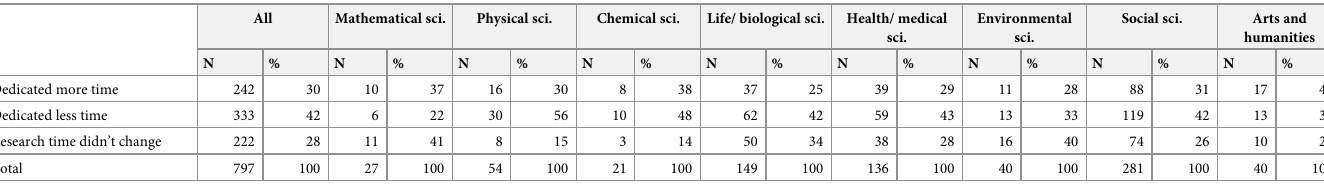
ECRs from the physical sciences formed the largest percentage of those who said they dedi- cated less time to research (56%), and they were followed by those from the chemical sciences (48%) (Table 4). The highest percentage of those who said that they dedicated more time were from arts and humanities (43%) and then from the chemical sciences (38%). The largest per- centage saying there was no change in research time devoted were from the mathematical sci- ences (41%) and environmental sciences (40%) ( X 2 = 30.3, df = 16, p = .005). Quite expectedly, those with caring responsibilities were more likely to dedicate less time to their research than before the pandemic (47.9% of those with vs 37.2% of those without caring responsibility) ( X 2 = 9.02, df = 2, p = .01), and those without caring responsibilities were more likely to dedicate more time to their research (32.6% of those without vs 27.4% of those with caring responsibili- ties). There was no gender or age difference. As illustrated in Table 5, there were significant differences between the seven countries ( X 2 = 29.4, df = 12, p = .003). Malaysia had the highest